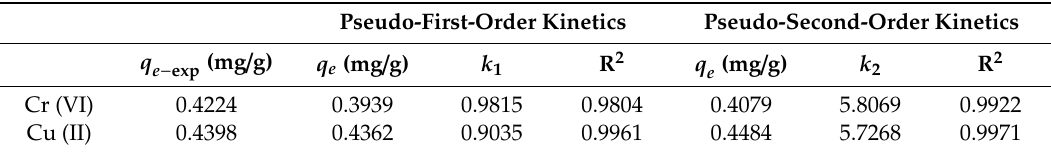
Table 2. Adsorption kinetic model rate constants for Cr(VI) and Cu(II) adsorption on the Fe 3 O 4